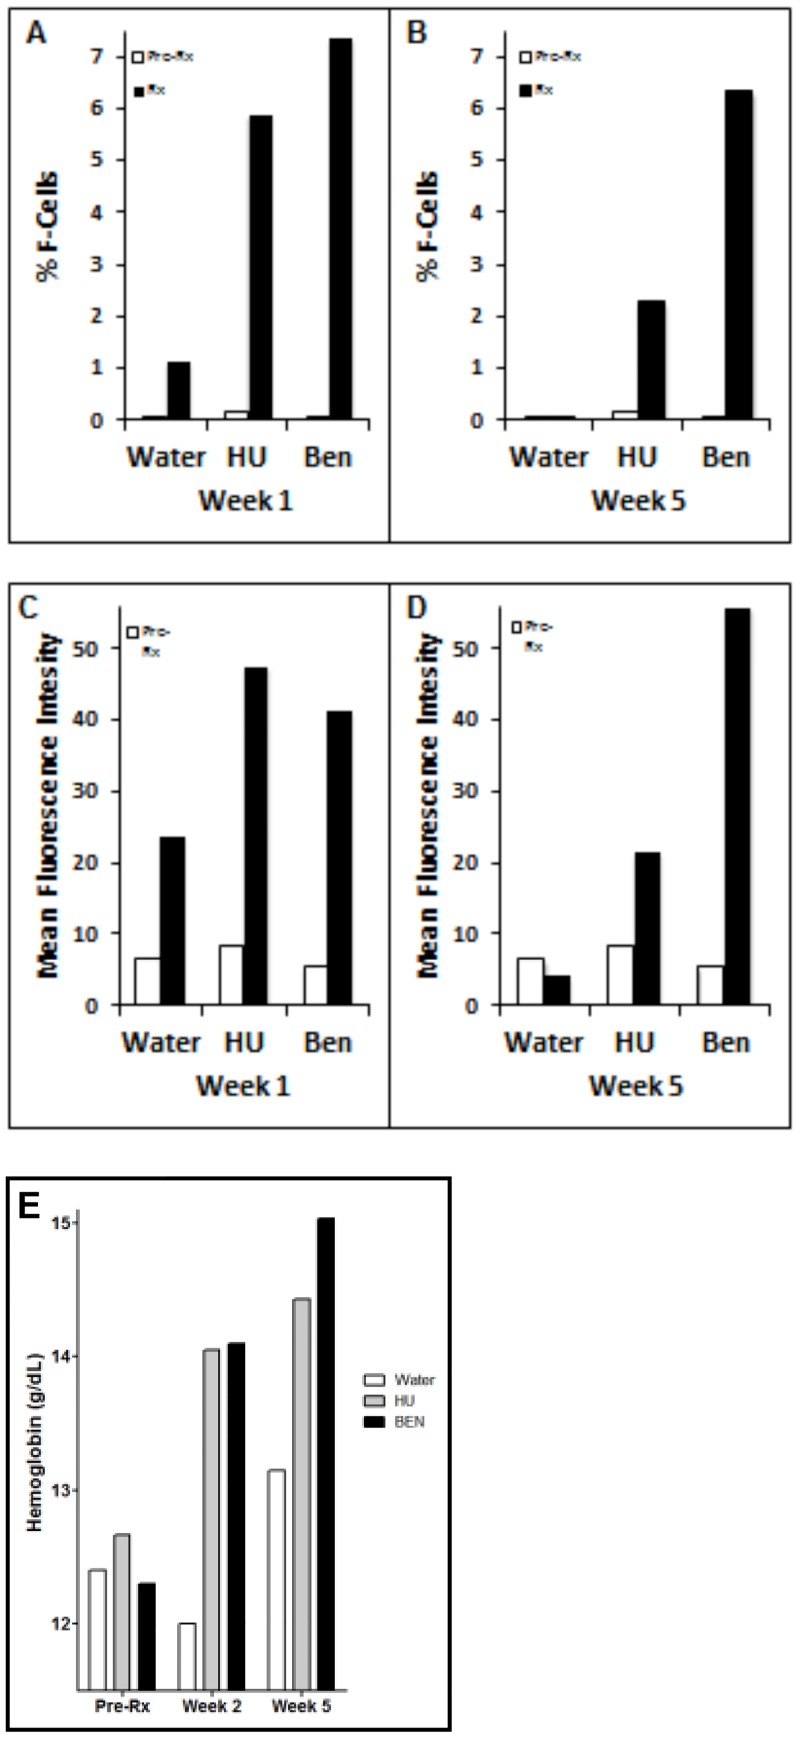
Responses of transgenic mice to treatment with Benserazide or Hydroxyurea.(A. & C.) Mice containing the human non-alpha globin genes in a YAC were treated with vehicle (water) as a control, Hydroxyurea (HU), or Benserazide. % F-cells and mean fluorescent intensity are shown pretreatment vs. 2 weeks after initiation of treatment, and (B. & D) pretreatment vs. 5 weeks after initiation of treatment. Changes with treatment were significant, (p<0.001 for Benserazide and p< 0.05 for Hydroxyurea). (E.) Total hemoglobin levels are shown pre- treatment vs. 2 weeks and 5 weeks after initiation of each treatment.